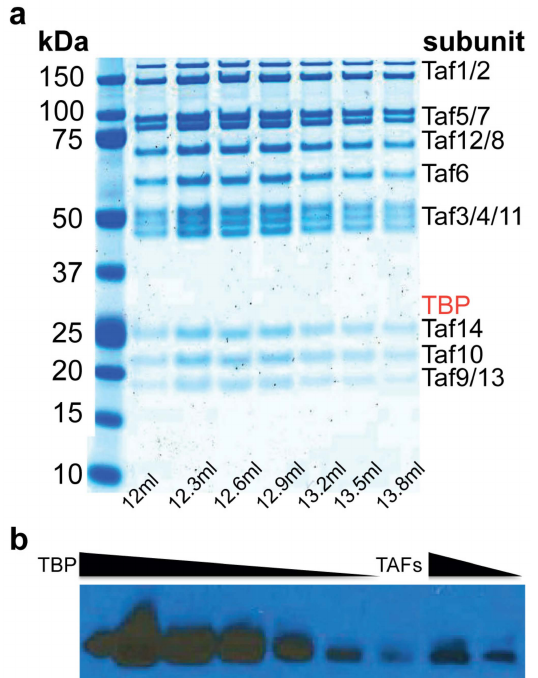
Figure 1. Purification of the TATA-box binding protein (TBP)-associated factor (TAF) complex. ( a ) SDS–PAGE of TAF complex fractions from size-exclusion chromatography. Elution volumes indicated. ( b ) Quantification of TBP in the TAF complex preparation by immunoblotting against known amounts of TBP revealed less than 3% TBP contamination (a two-fold dilution series of recombinant TBP from 2 pmoles to 12.5 fmols and 2 and 1 pmols of purified TAF complex were loaded on the gel). 2.2. The TAFs Alone Bind and Introduce Significant Topological Changes to the TATA-Less RPS5